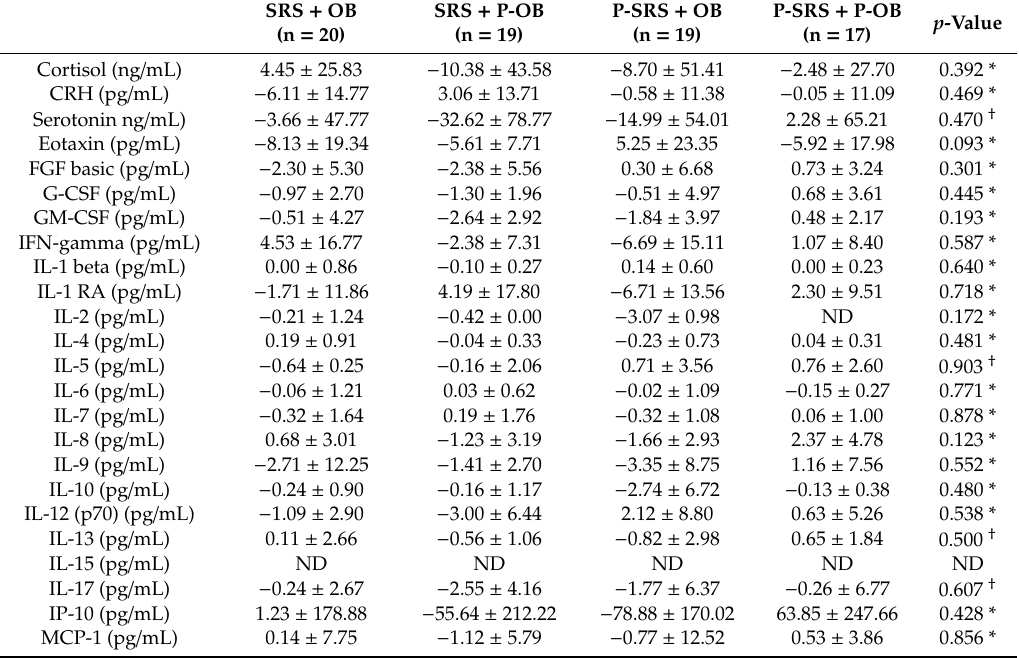
Table 6. Blood chemistry and immunologic test results (ITT